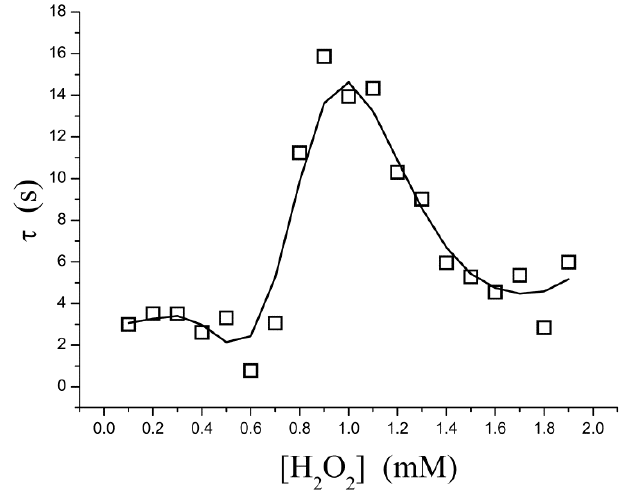
Figure 3. Effect of the concentrations of H pre-steady-state